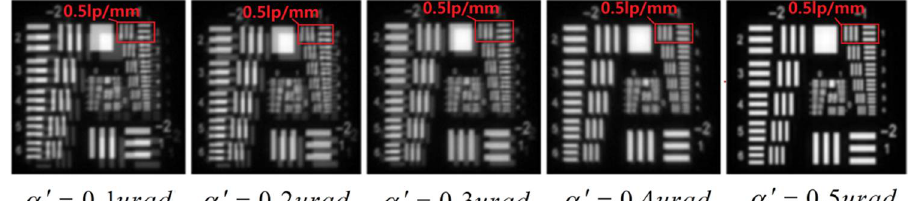
Figure 15. Tilt error correction simulation.